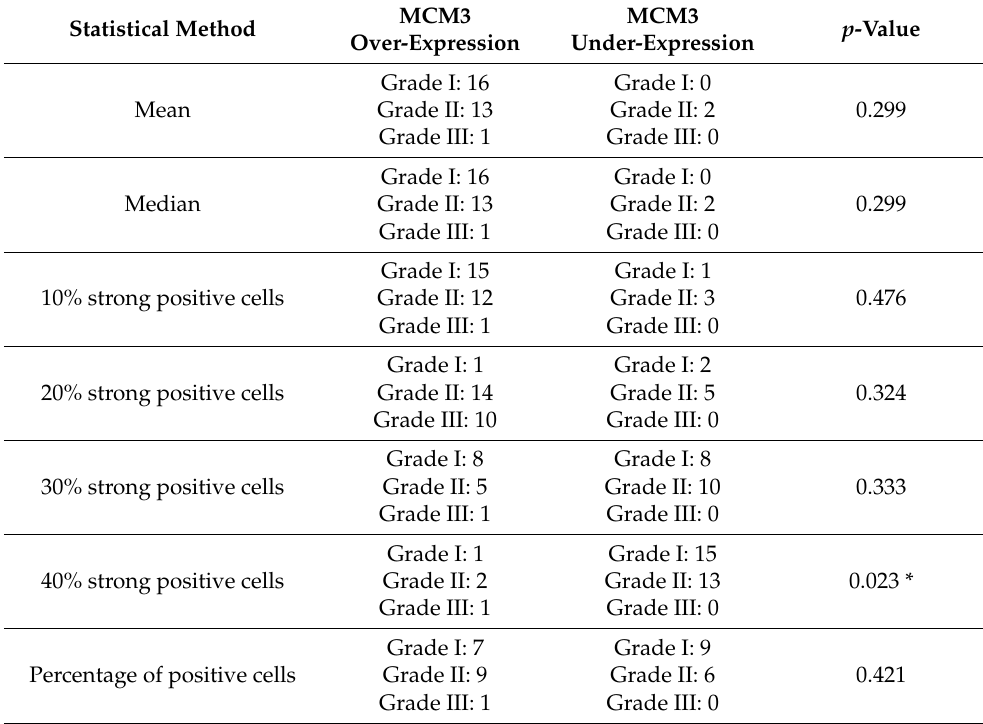
Table 7. MCM3 expression correlation with Aneroth’s grading system.